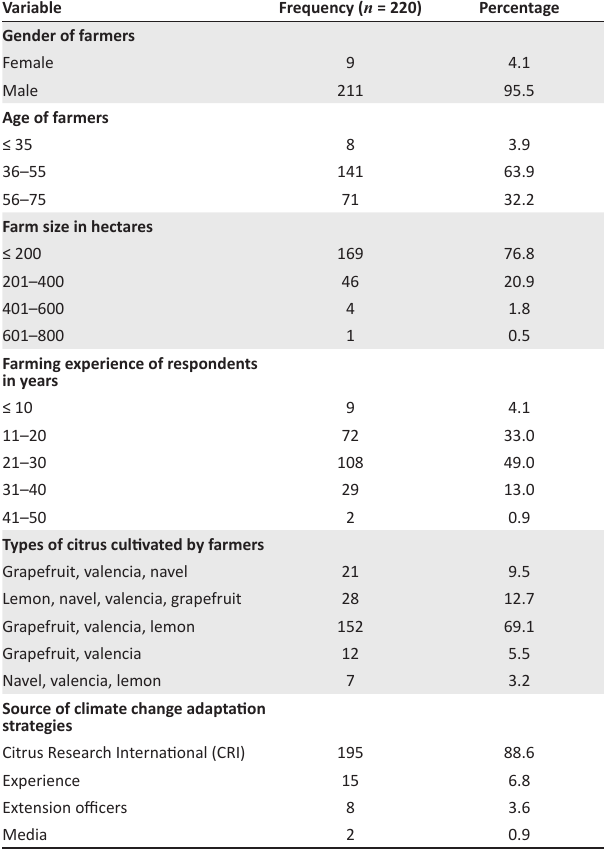
TABLE 1: Demographic and socioeconomic characteristic of respondents.